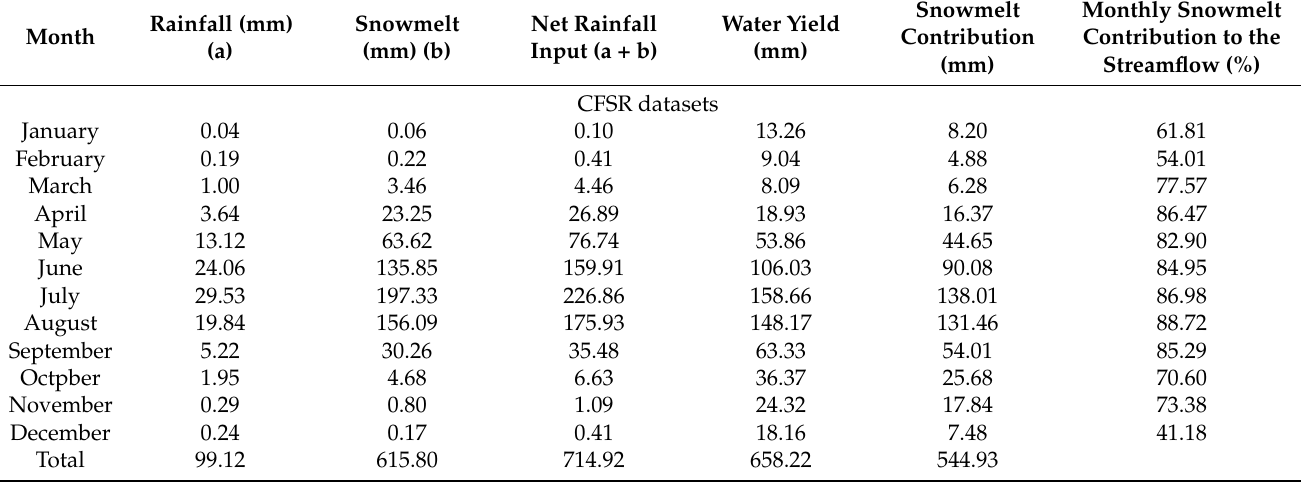
Table 6. Average monthly snowmelt contribution in the Upper Vakhsh River flow, by coupling the SWAT model with the CFSR and CRU TS3.1, during the overall period of the SWAT model